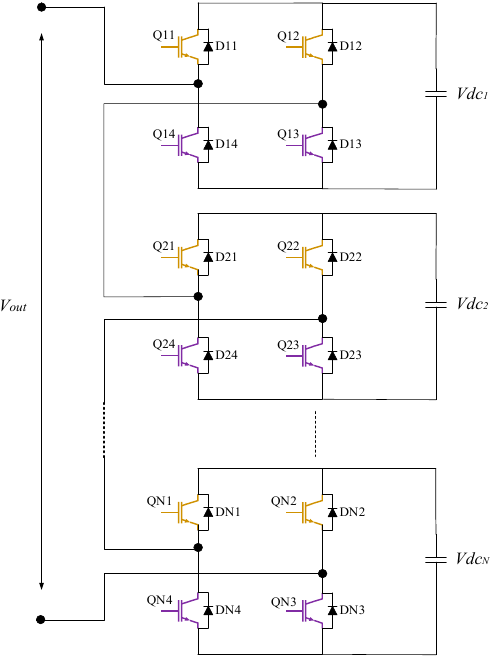
Figure 5. Three-phase CHB VSC converter.